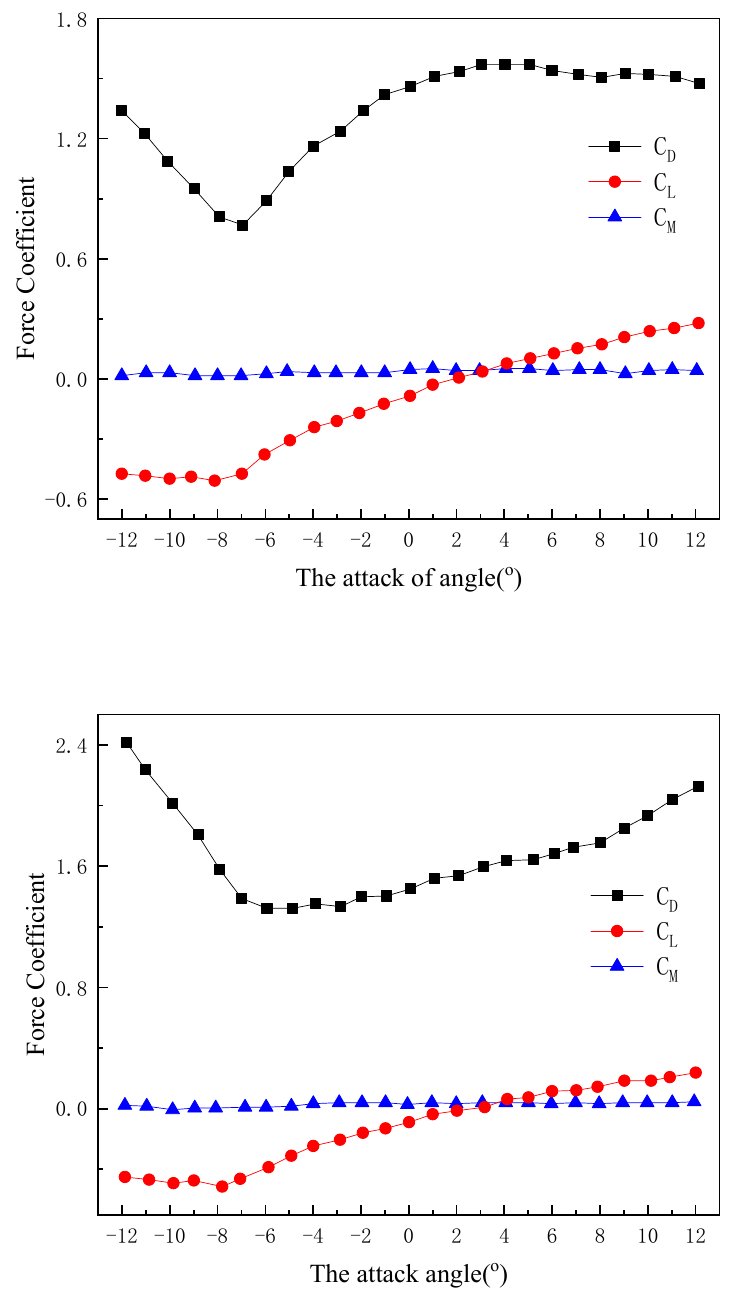
Figure 3. Drag, lift, and moment coefficient curves (body-axes system and wind-axes system).